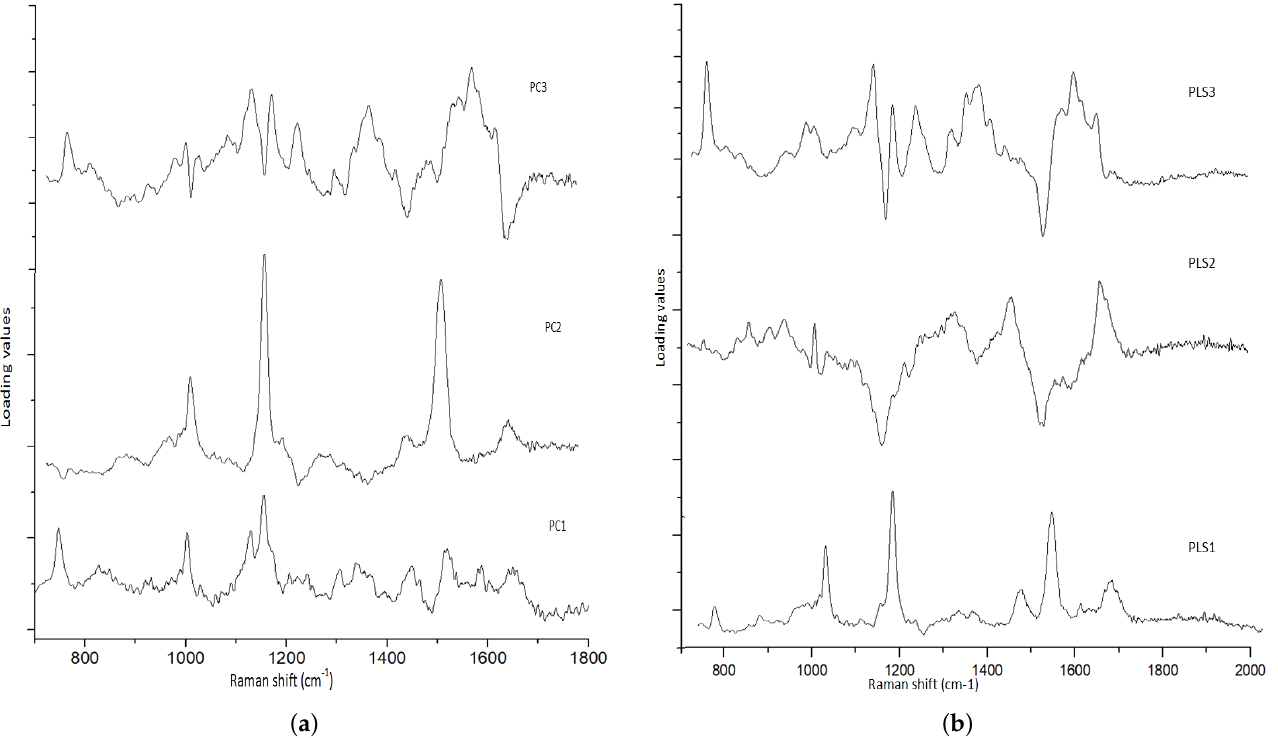
Figure 4. Loading plot of ( a ) PC components (PCs) and ( b ) PLS components (LVs) in each model calculated from the Raman spectra of oral